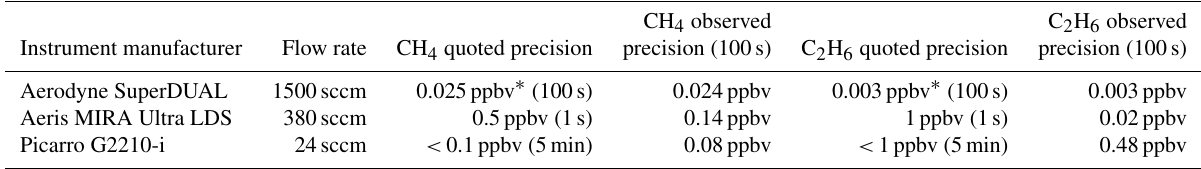
Table 3. Summary of various instrument performance metrics. The quoted precisions are from the Product Datasheet for each analyzer.